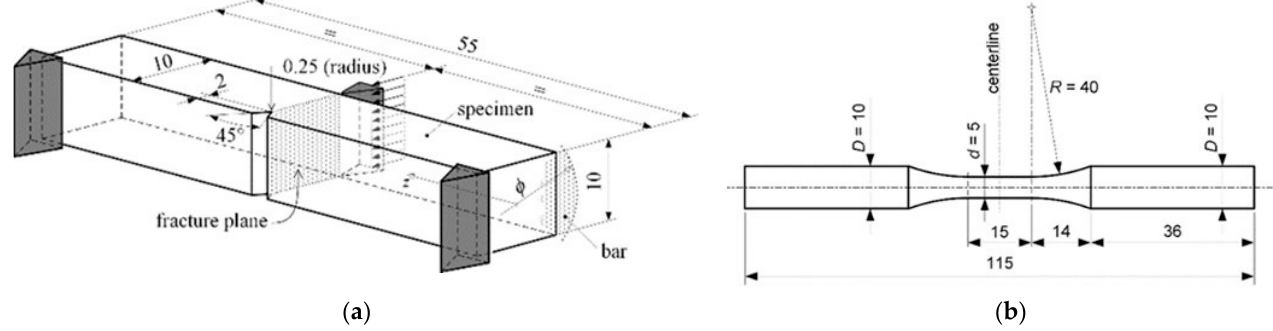
Figure 1. Specimens used in experimental tests (mm): ( a ) Charpy impact test and ( b ) Uniaxial fatigue test